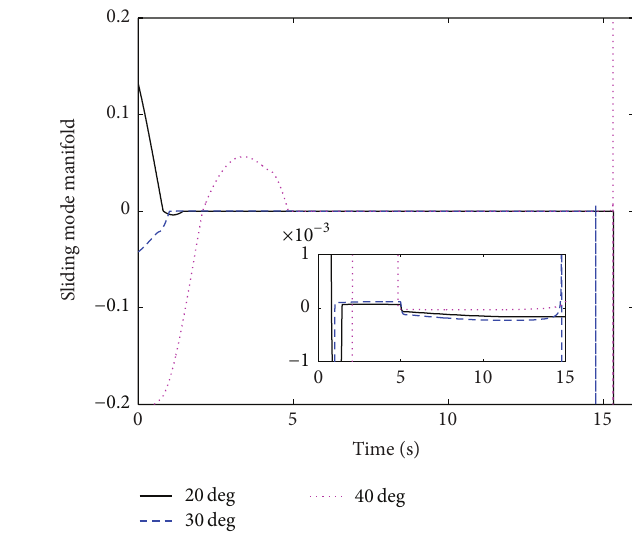
Figure 37: Trajectories of missile and target.